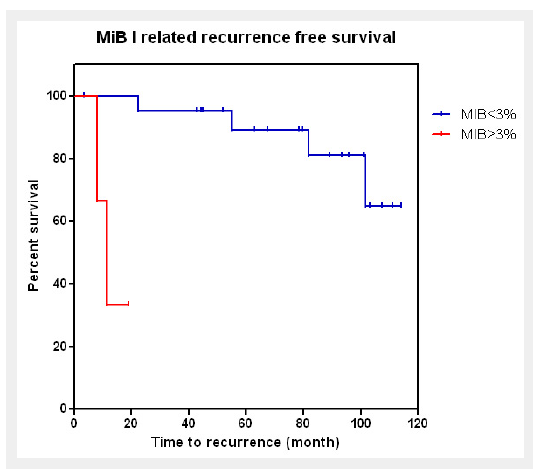
Kaplan-Meier curve showing age and recurrence free survival.